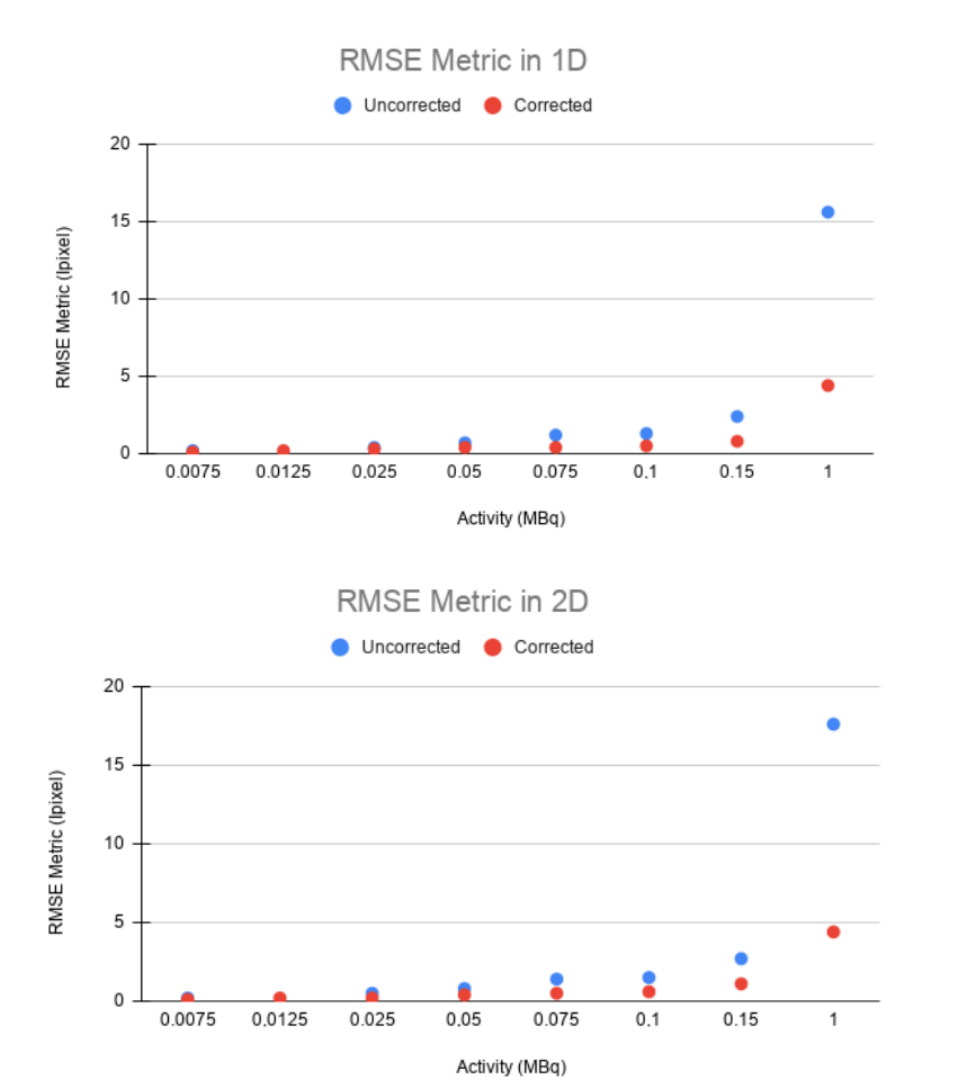
Figure 9. Root mean square error (RMSE) values for 1D ( top ) and 2D ( bottom ) for static-uncorrected and static-corrected image